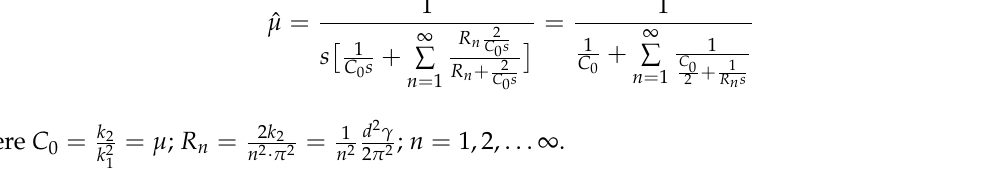
in the form of an R,L ˆ µ